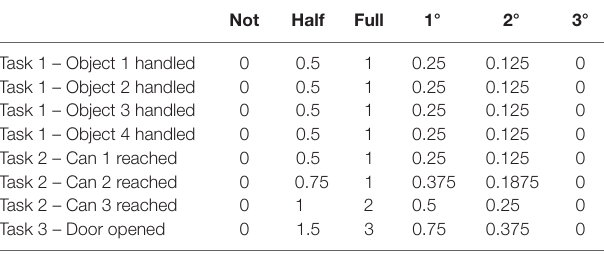
tABLe 3 | scoring of the manipulation.